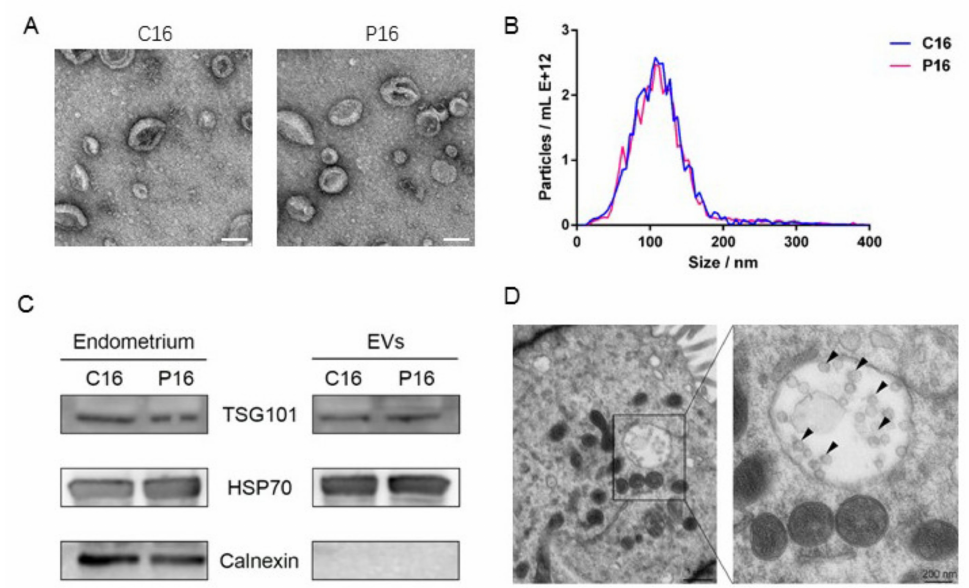
Figure 1. Characterization of EVs from porcine UFs. ( A ) TEM analysis of extracellular vesicles from goat UFs. Scale bar = 100 nm. ( B ) NTA of the extracellular vesicles from goat UFs. ( C ) West- ern blotting detected EV protein markers, TSG101 and HSP70, in the UFs’ EVs fraction and the endometrium. Endoplasmic reticulum membrane marker (Calnexin) was only detected in the en- dometrium. ( D ) TEM analysis of endometrial luminal epithelium on day 16 of pregnancy ( n = 3). Legend: C16, on day 16 of the estrous cycle; P16, on day 16 of pregnancy. Arrowhead refers to